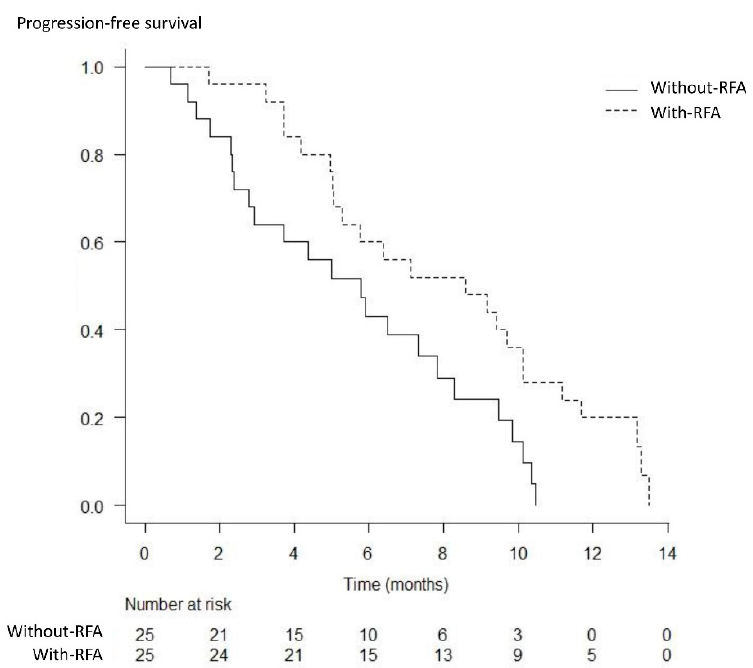
Figure 4. Kaplan–Meier analysis of the progression-free survival. The median progression-free sur- vival was significantly higher in the with-RFA group than that in the without-RFA group (8.6 months versus 5.8 months, p = 0.014).